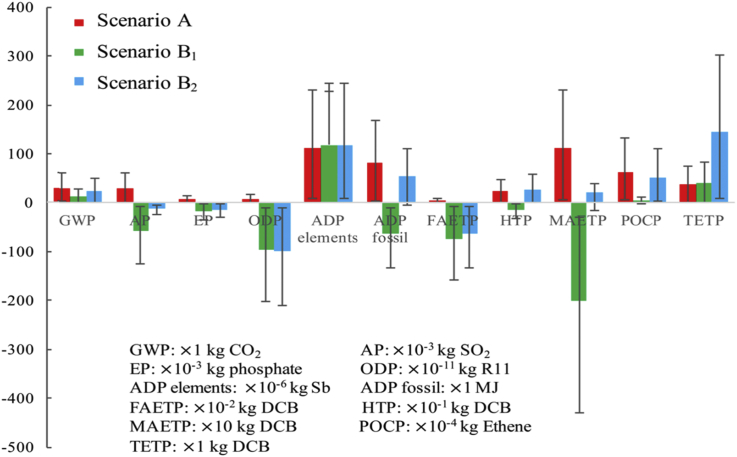
Comparative environmental profiles for SB1 and SB2.